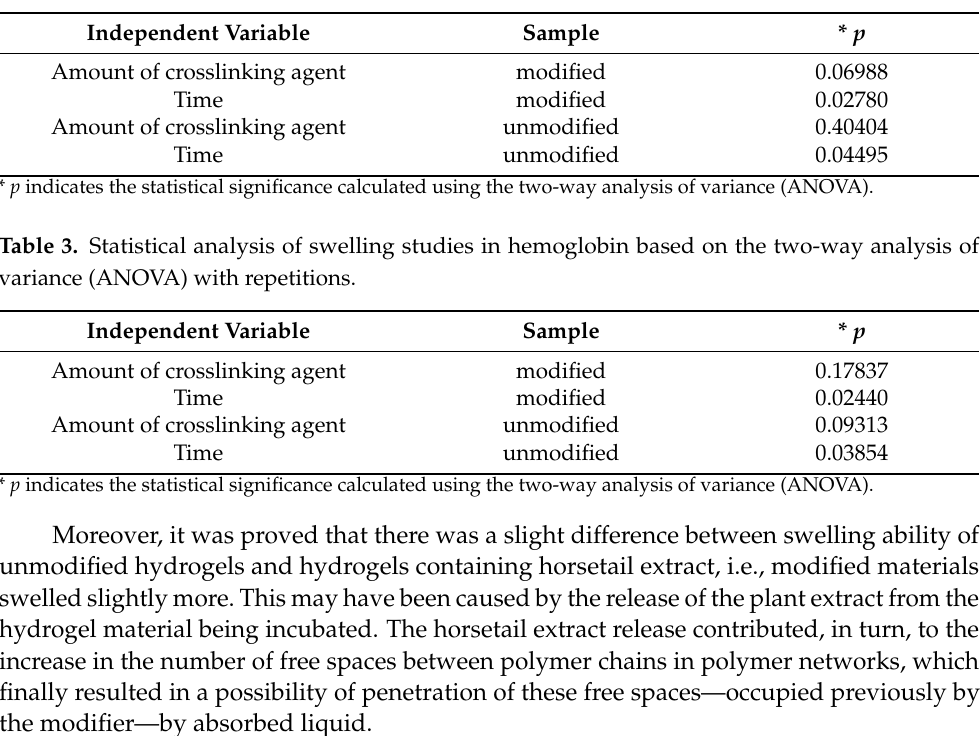
Figure 4. Swelling in hemoglobin of unmodified hydrogels ( a ) and hydrogels modified with 10 mL of Equisetum arvense L. extract ( b ) (number of repetitions n = 3). Table 2. Statistical analysis of swelling studies in SBF based on the two-way analysis of variance (ANOVA) with repetitions.